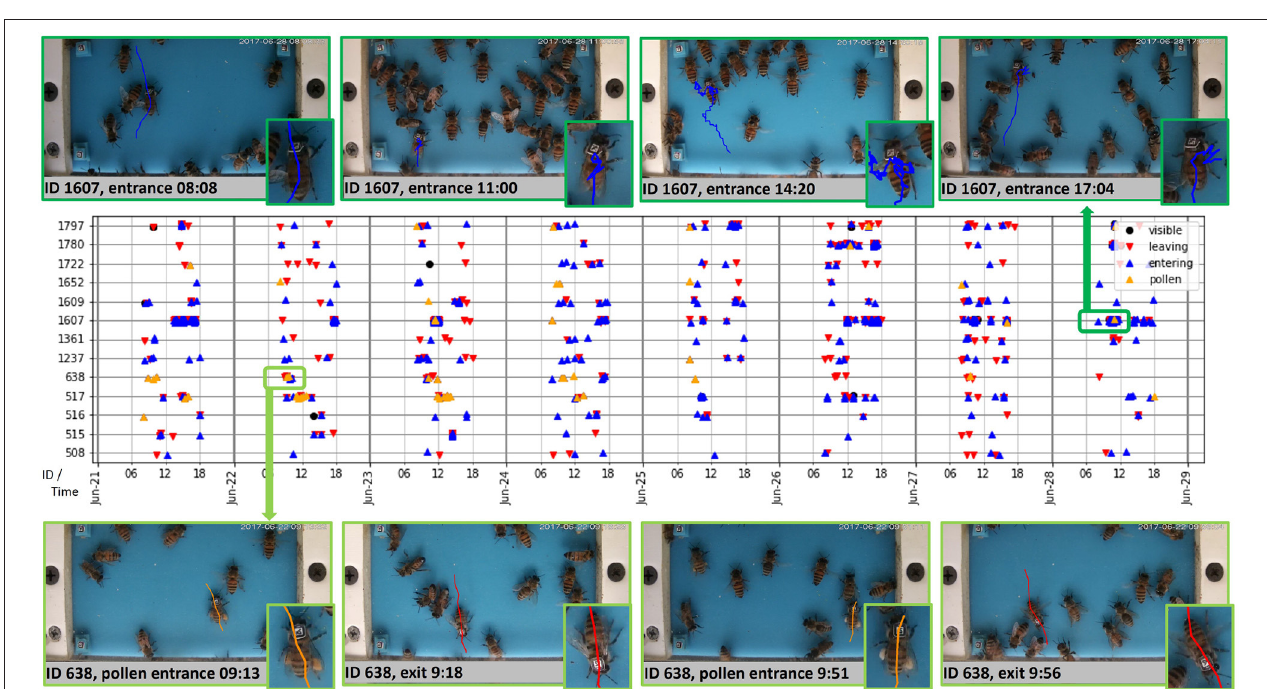
FIGURE 8 | Timeline of foraging events for several tagged bees over the span of 8 days (Middle), with the example of trajectories for bee #1607 (Top) and bee #638 (Bottom). Video analysis was performed from 8:00 to 17:59 each day from June 21 to June 28, 2017. The timeline shows the individual patterns of behavior of each bee over multiple days. The images show a sampling of event types (entrance, entrance with pollen, exit), luminosity conditions (after sunrise, daylight, before sunset), and ramp crowding (8–30 bees). The trajectories shown in these plots are based on the center of the body which may be slightly shifted from the tag position.